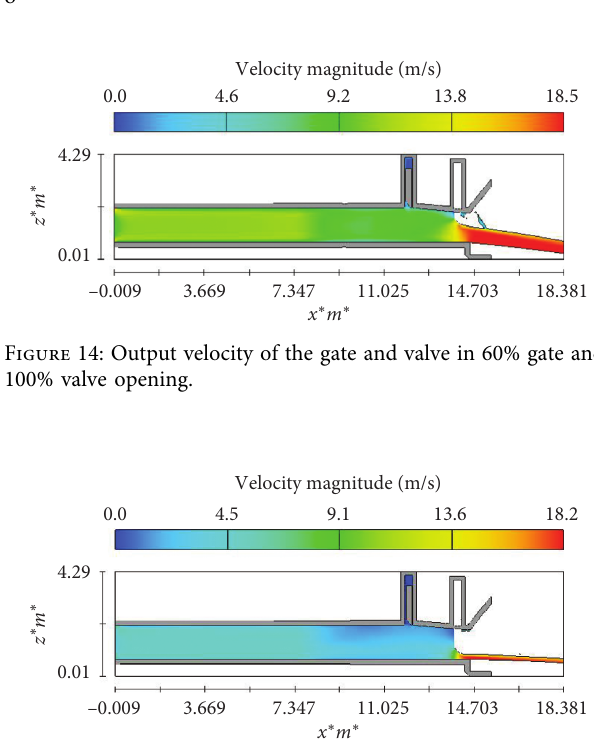
Figure 15: Output velocity of the gate and valve in 20% gate and 100% valve opening.